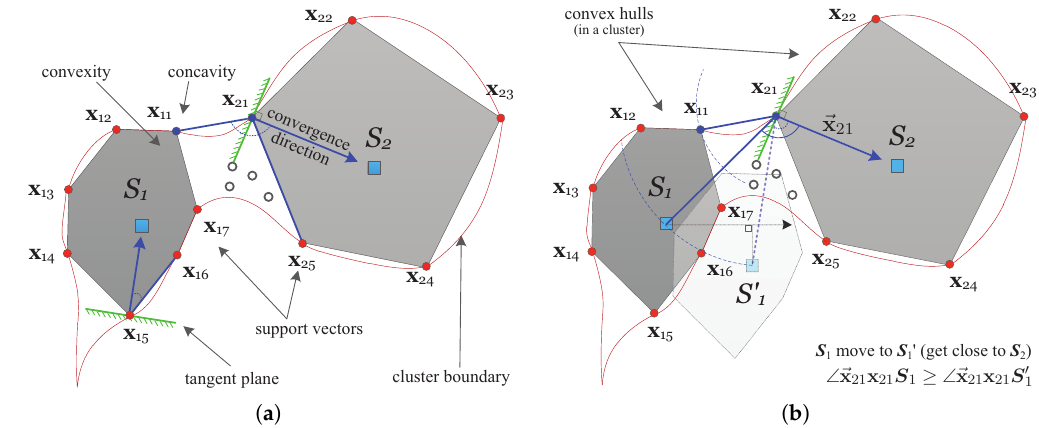
Figure 2. Diagram for the principles of convex decomposition and connectivity analysis: ( a ) convex decomposition; and ( b ) connectivity